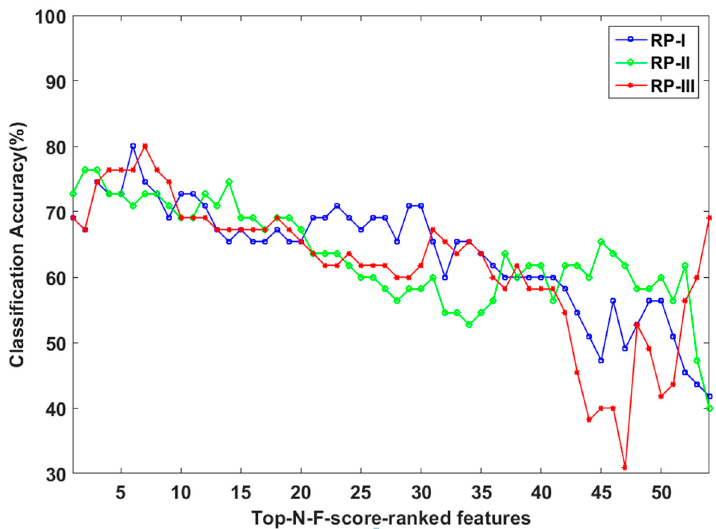
Figure 8. Classification accuracy obtained by each top- N -F-score-ranked feature set in the emotion-induction state. The best N for RP-I, RP-II, and RP-III features are 6, 2, and 7, where the classification accuracies are 80.00%, 76.36%, and 80.00%, respectively.